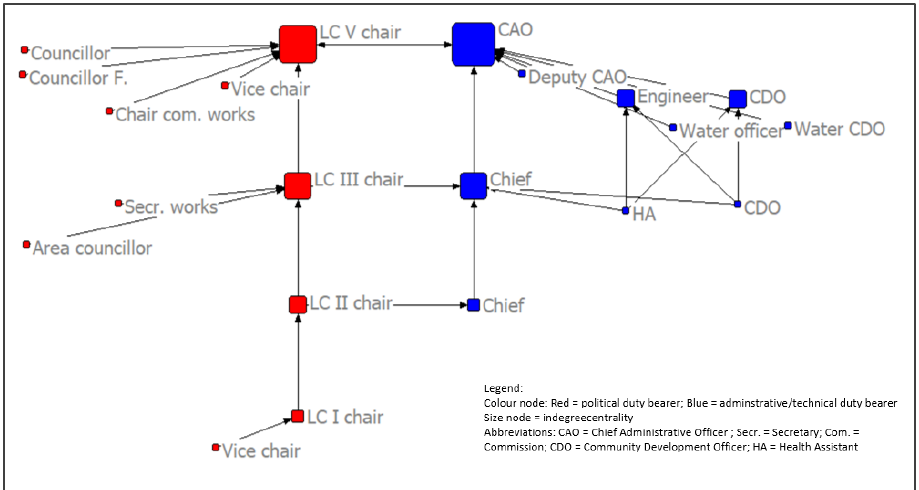
Figure 3a: Theoretical ‘reporting’ network